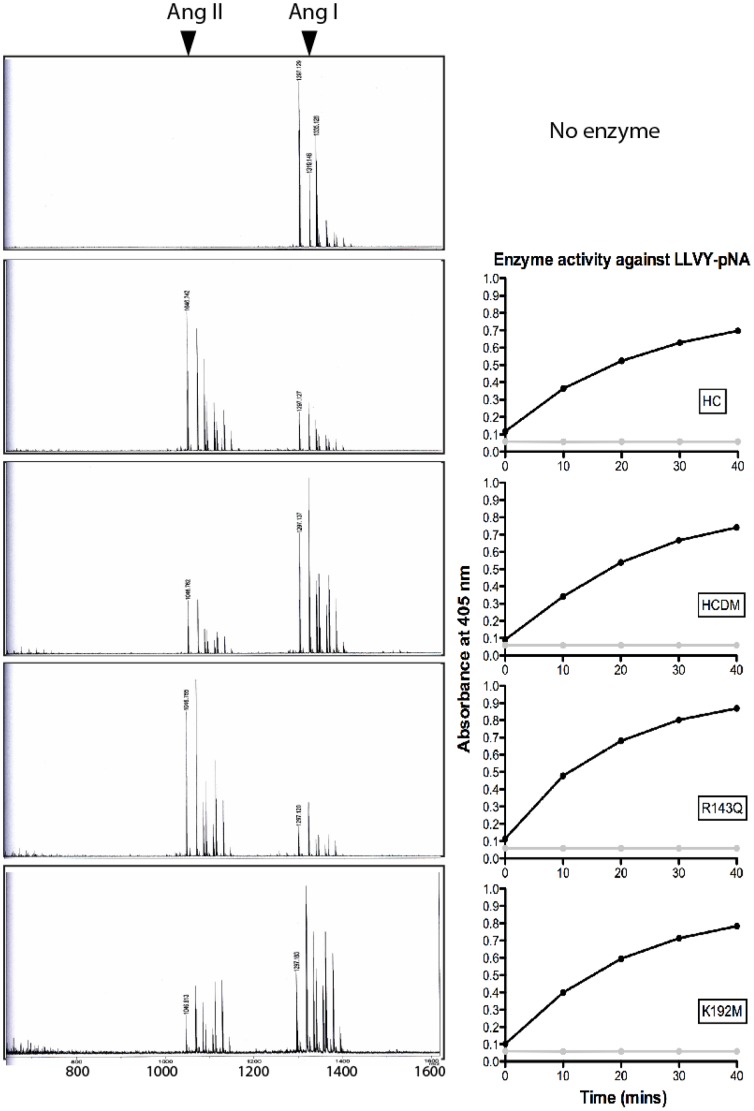
The effect of mutations in Arg143 and Lys192 mutants on the processing of Ang I.The Arg143 and Lys192 variants ability to process Ang I was analysed by cleaving 10 µg of Ang I in a 20 µl reaction volume. Ang I (Asp1-Arg2-Val3-Tyr4-Ile5-His6-Pro7-Phe8-His9-Leu10, MW∼1297) is converted to Ang II (MW∼1046) by cleavage after the Phe8 bond. As reference samples we also used the wt enzyme and the double mutant (Arg143+Lys192). Approximately the same amount of protease, as determined by cleavage of the chromogenic substrate LLVY-pNA, was used in each reaction (Right panel). Two µl samples were removed at different time points and analysed by mass spectrometry. The obtained results were compared in order to estimate the generated products aswell as a semi-quantitative measurement of the cleavage rate and its dependence on residues Arg143 and Lys192 and the double mutant. These experiments were independently performed three times with similar results.